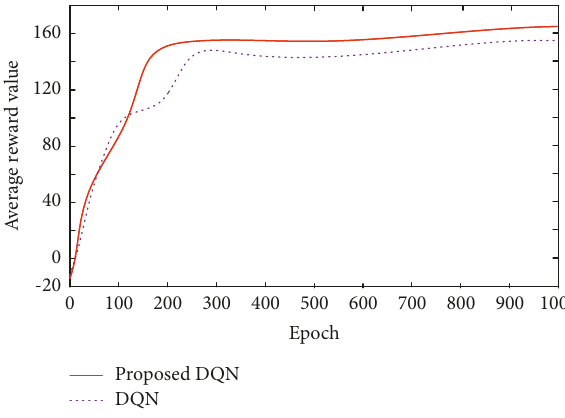
Figure 6: Comparison of average reward values.